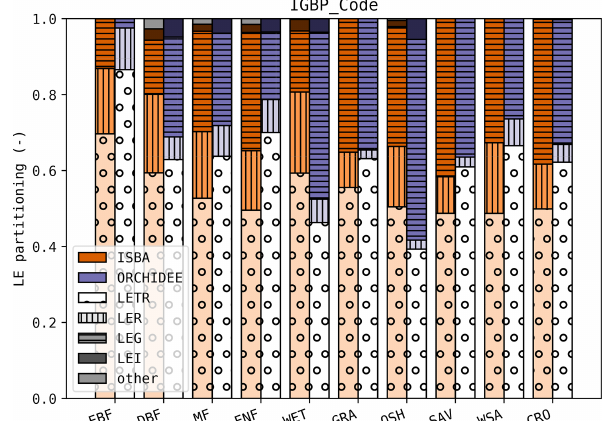
Figure 9. Average LE partitioning per PFT class in ISBA and OR- CHIDEE. LETR: transpiration; LER: intercept evaporation; LEG: soil evaporation; LEI: ice/snow evaporation; other: including evap- oration from flooded